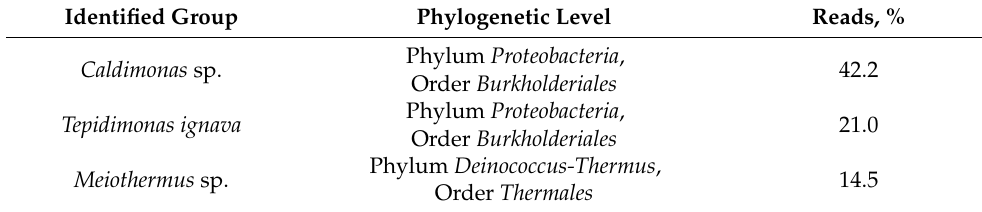
Table 1. Taxonomic groups identified in